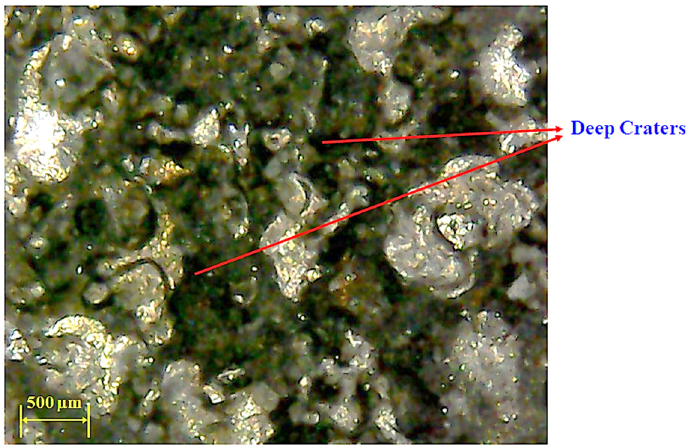
Figure 7. Micrograph of machine cavity showing deep craters at 10 amps using brass electrode.